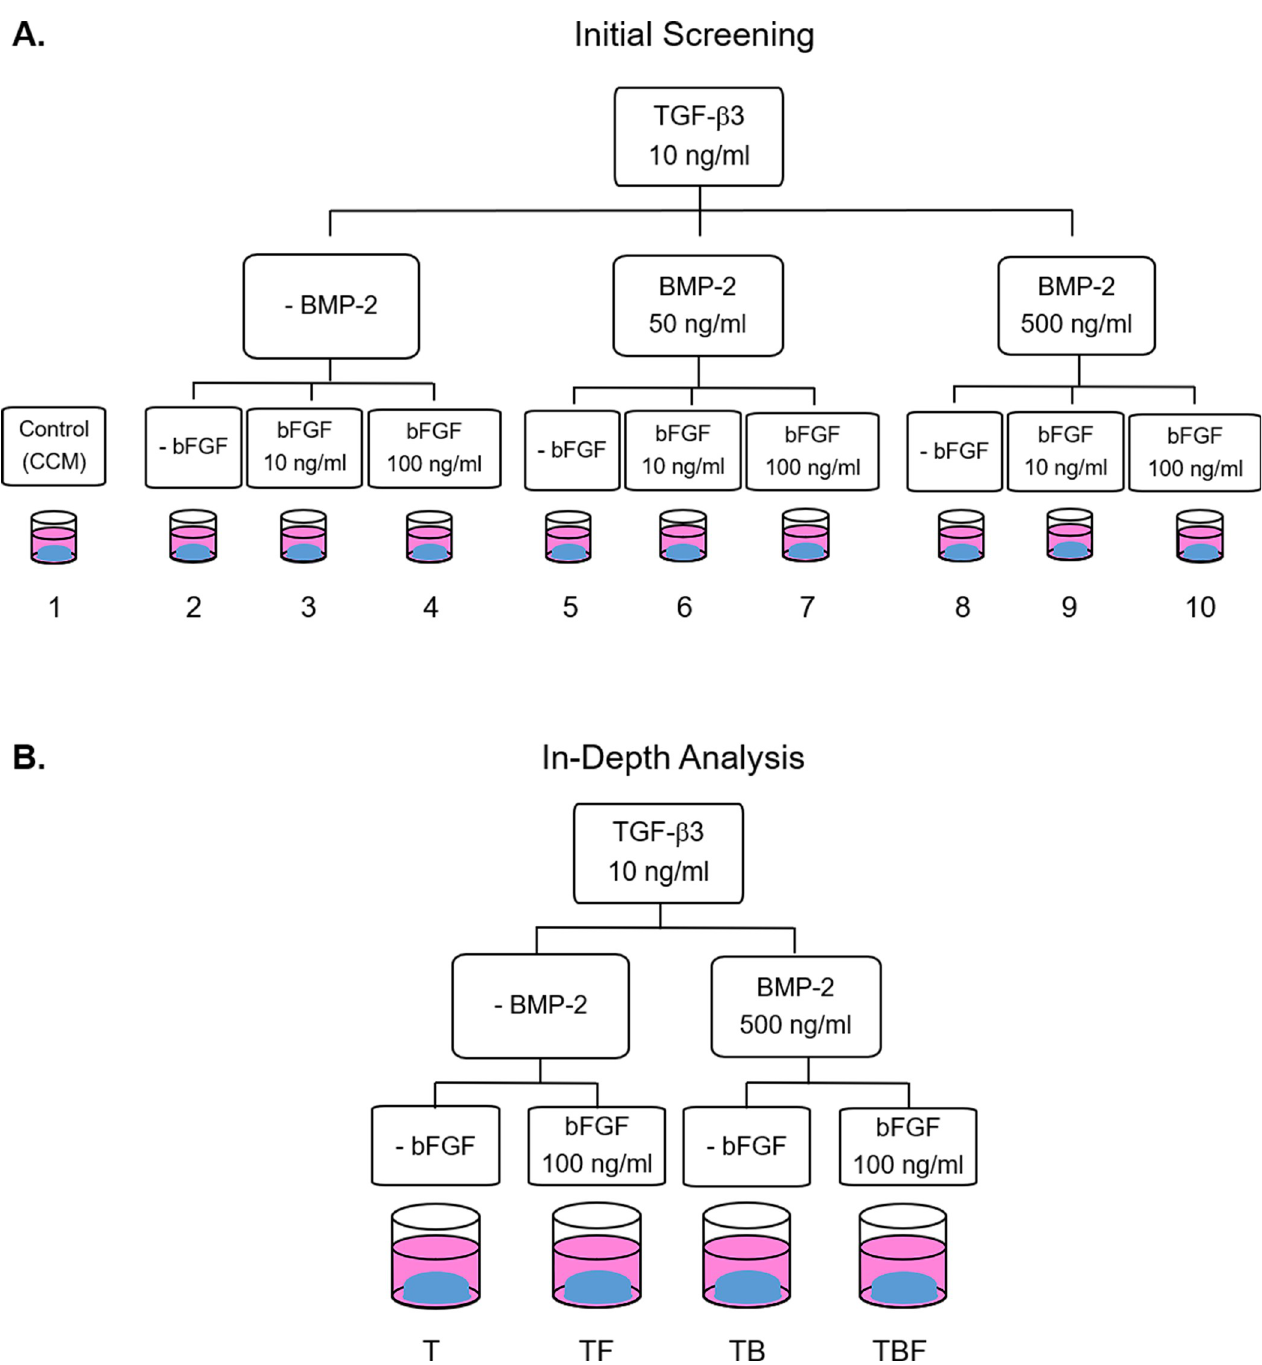
Fig 2. Experimental outline. A) In initial screening studies, 10 treatment conditions were assessed using gross photography, construct weight, and histology. For constructs cultured in chondrogenic media, chondrogenic basal media was supplemented with 10 ng/mL TGF- β 3 and various combination of BMP-2 (50 or 500 ng/mL) and bFGF (10 or 100 ng/mL). Constructs were assessed by gross photography, construct weight, and 1% toluidine blue histology. B) Based on results from the screening studies described in panel A, four promising conditions were selected for in-depth analyses.